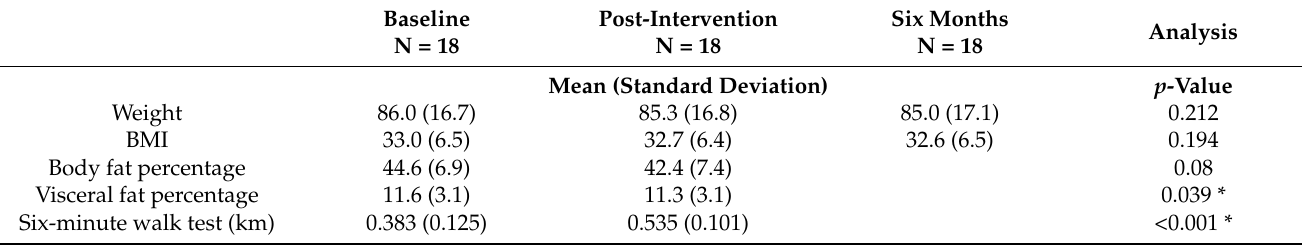
Table 4. Anthropometric outcomes over